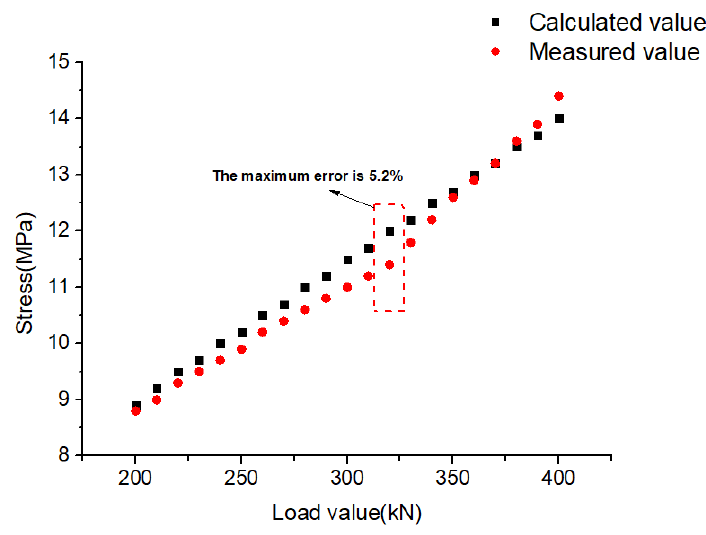
Figure 4. Stress comparison between numerical results and measured results.